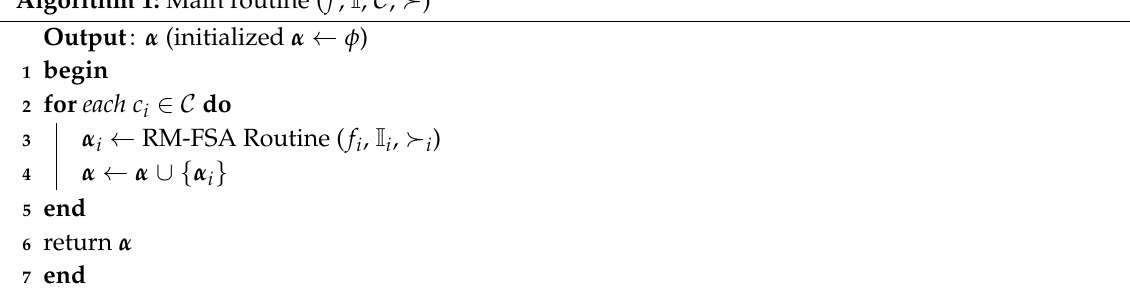
Algorithm 1: Main routine ( f , I ,